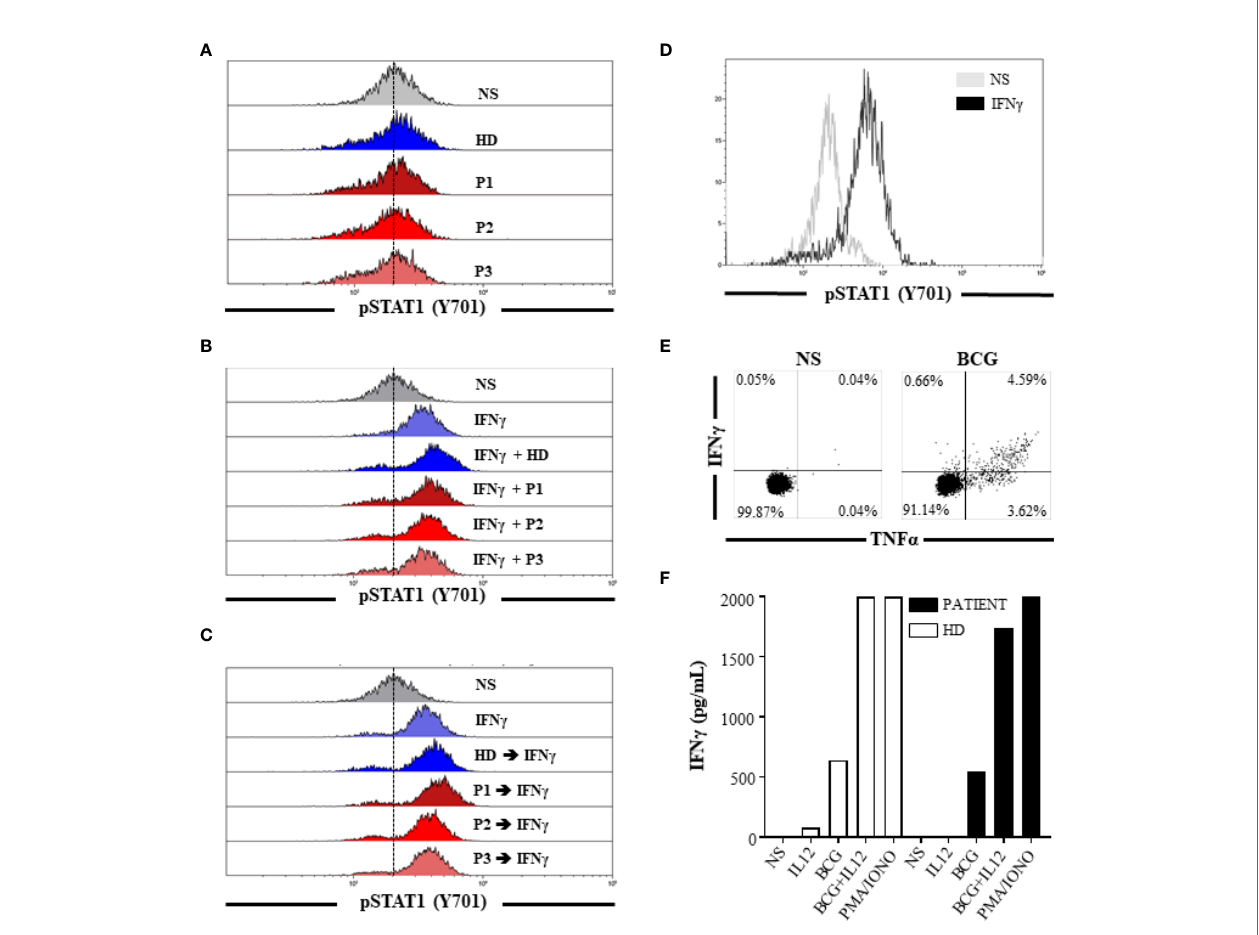
FIGURE 3 | Absence of IFN g or other autoantibodies that may directly hinder/block IFN g signaling and normal response to IFN g or BCG stimulation. STAT1 phosphorylation (Y701) of HD monocytes after stimulation for 15 min (A) with 25% (v/v) allogenic HD or patient ’ s serum (from different time points: P1, P2, and P3) and (B) with IFN g previously mixed with 25% (v/v) allogenic HD or patient ’ s serum (from different time points: P1, P2, and P3). (C) STAT1 phosphorylation (Y701) of HD monocytes after IFN g stimulation for 15 min. Cells were preincubated 30 min at room temperature in the presence of 25% (v/v) HD or patient ’ s serum (from different time points: P1, P2, and P3) and washed before IFN g stimulation. (D) STAT1 phosphorylation (Y701) of monocytes from the patient after IFN g stimulation for 15 min. (E) Frequency of IFN g + and/or TNF a + CD4 + T cells from the patient after no stimulation or stimulation with heat inactivated BCG for 48 h. (F) IFN g concentration in culture supernatant after no stimulation, IL12, heat-inactivated BCG, or PMA/IONO stimulation of PBMC from the patient and one HD for 48 h. BCG: bacillus Calmette-Gue ́ rin; HD, healthy donor; IFN g , interferon gamma; NS, non-stimulated; P1, patient ’ s serum before BCGosis diagnosis and IFN g therapy (2018-08); P2, patient ’ s serum at the time of BCGosis diagnosis and during IFN g therapy (2018-11); P3, patient ’ s serum after BCGosis diagnosis and IFN g therapy